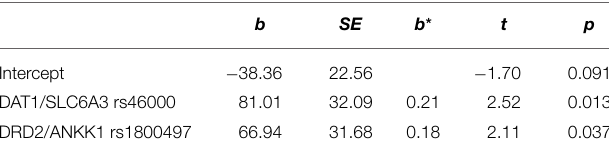
FIGURE 2 | The interaction of physical exercise (control, exercise) and order of conditions (control-exercise, exercise-control) on the speed measures of switch costs. Post-hoc tests were Bonferroni corrected. ** p < 0 . 01 .